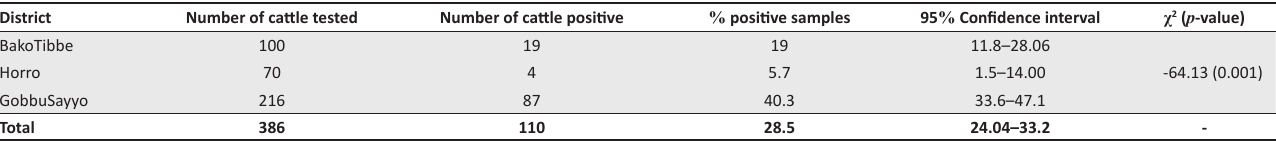
TABLE 2: Seroprevalence of contagious bovine pleuropneumonia in individual animals in the sampled villages. Site (villages) Number of animals tested